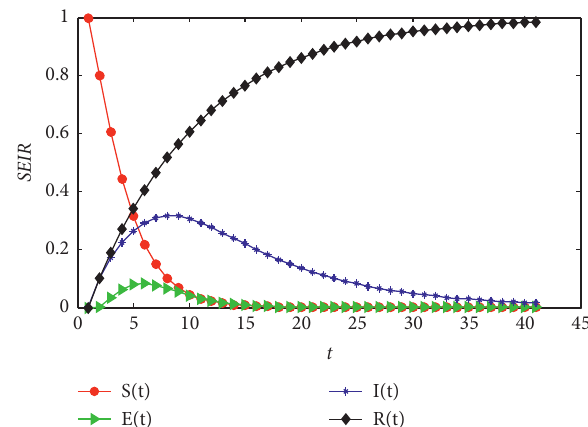
Figure 8: Change trend of SEIR model (3) (when μ 1 � 0.4, μ 2 � 0.1, μ 3 � 0.1, α � 0.3, and c � 0.1, the change of four independent states of the credit subject trend over